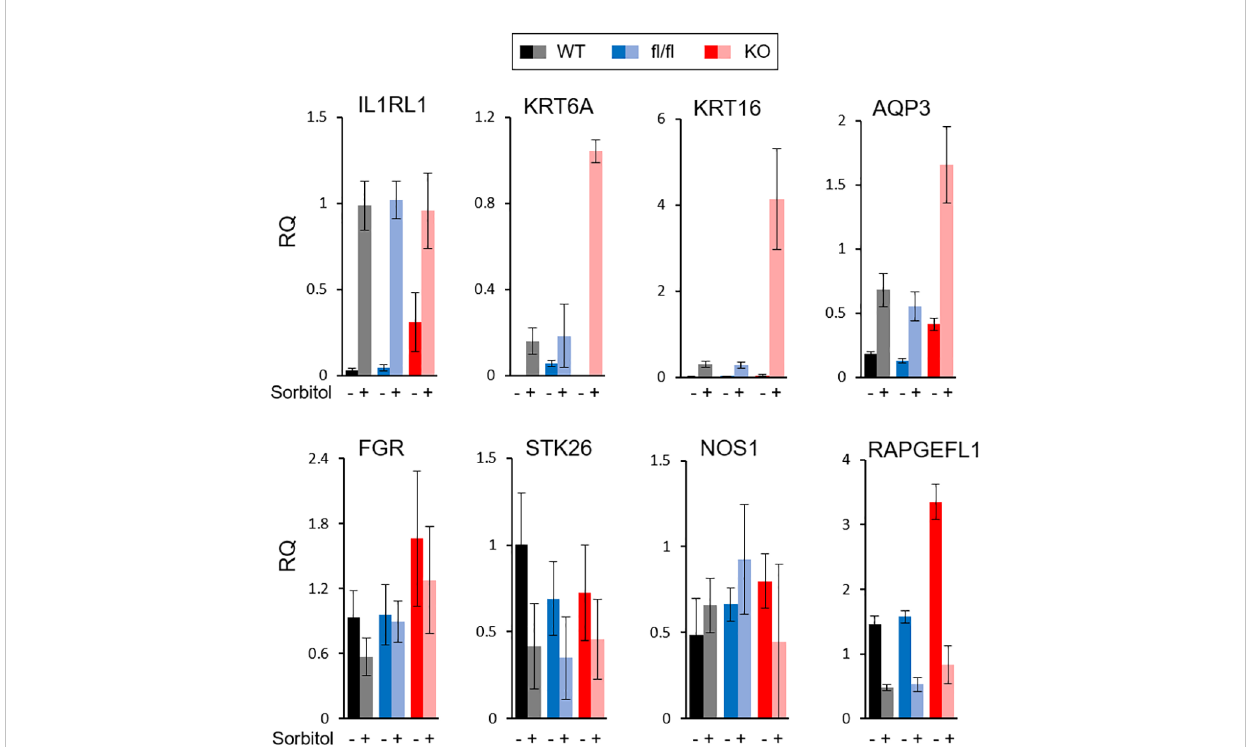
FIGURE 4 Analysis of gene expression in TRAF7 de fi cient cells. mRNA expression analysis of several TRAF7-dependent DEGs (as labeled above each graph panel) in TRAF7 +/+ (WT), TRAF7 fl / fl ( fl / fl ), and TRAF7 -/- (KO) mouse embryonic fi broblasts un-stimulated (-) or stimulated (+) with 0.2M sorbitol as marked. Total RNA was puri fi ed 16 hours post-stimulation and mRNA was ampli fi ed by RT-qPCR using GAPDH as internal control. Bars represent mRNA fold change over mRNA value in un-stimulated WT. Data are presented as relative quantity (RQ) Mean ±